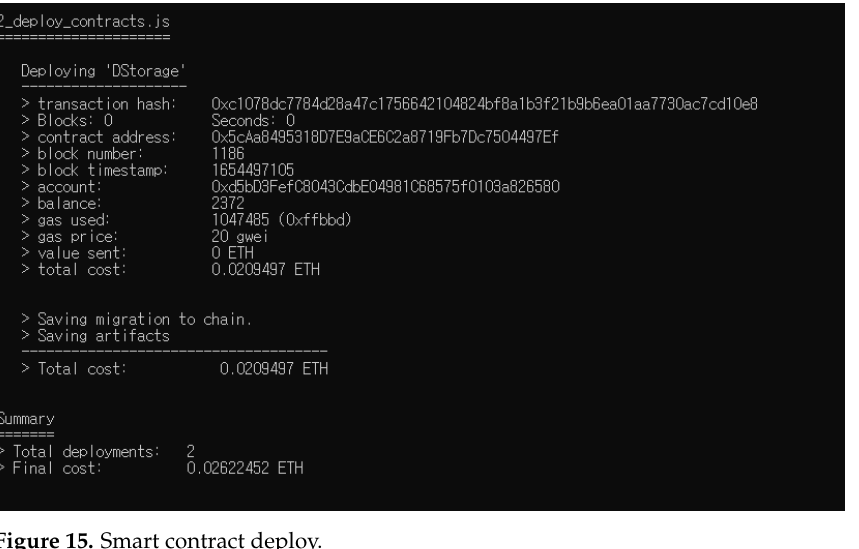
Figure 15. Smart contract deploy.